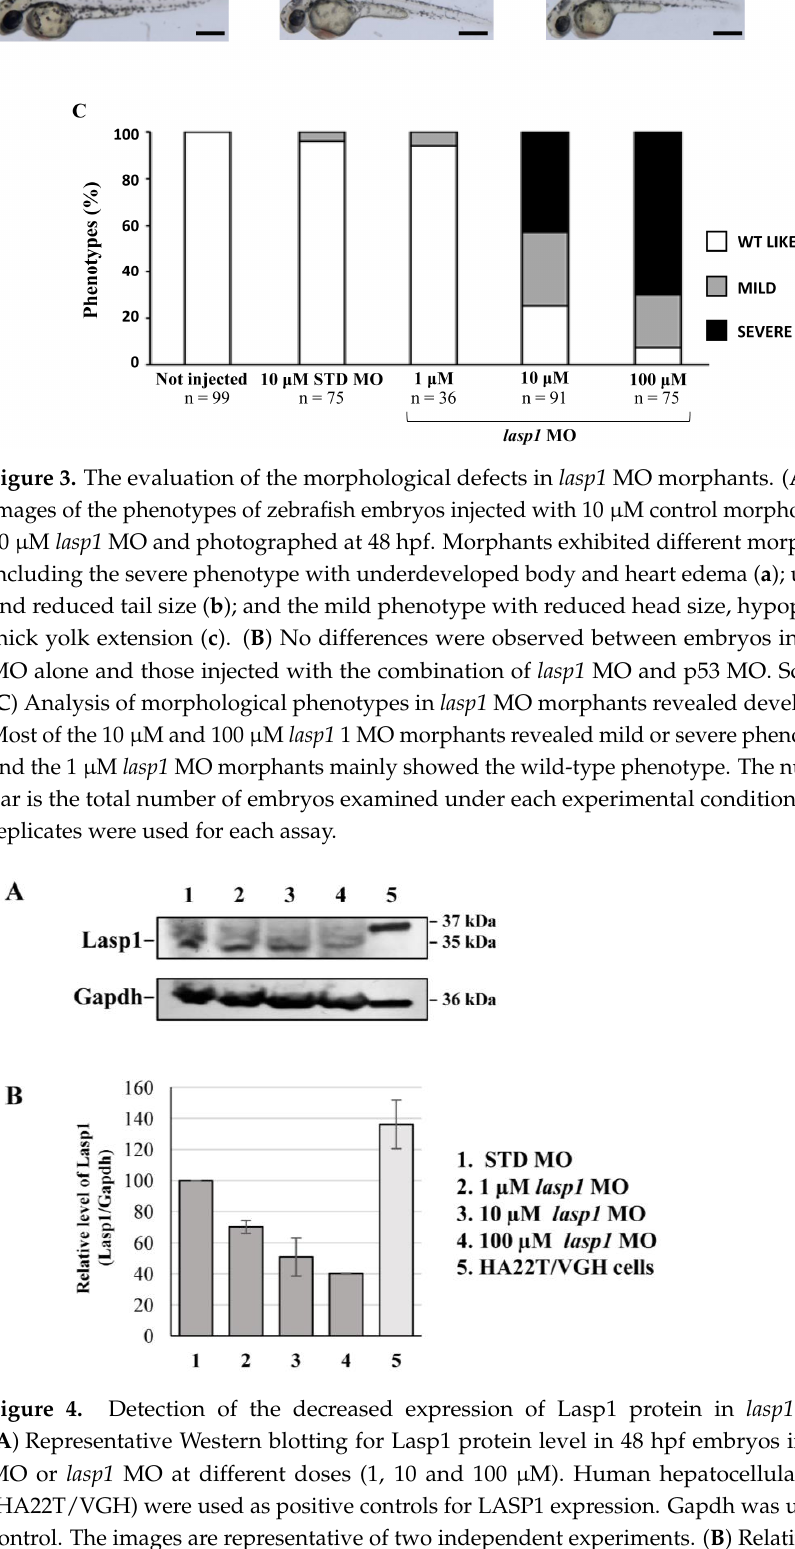
Figure 5. Absolute quantifications of lasp1 mRNA in lasp1 MO morphants using ddPCR. Dose-de- pendent increases in lasp1 mRNA levels were observed. The graph represents the average values of copies /μL referred to the MO STD samples; error bars are SDs. ** p < 0.01 in one-way ANOVA fol- lowed by Bonferroni testing.